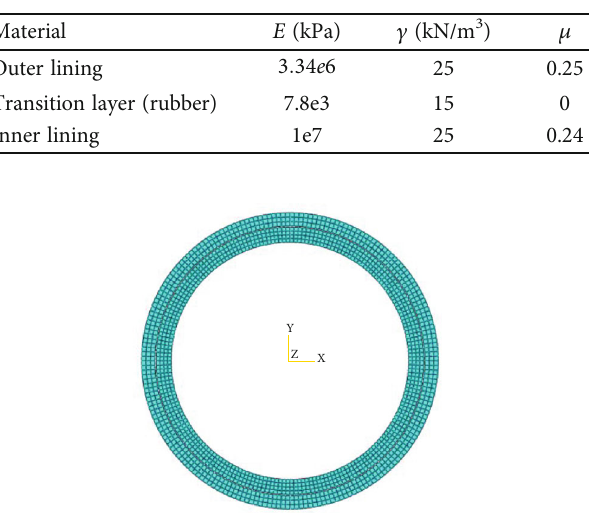
Table 1: Material parameter table for model calculation.